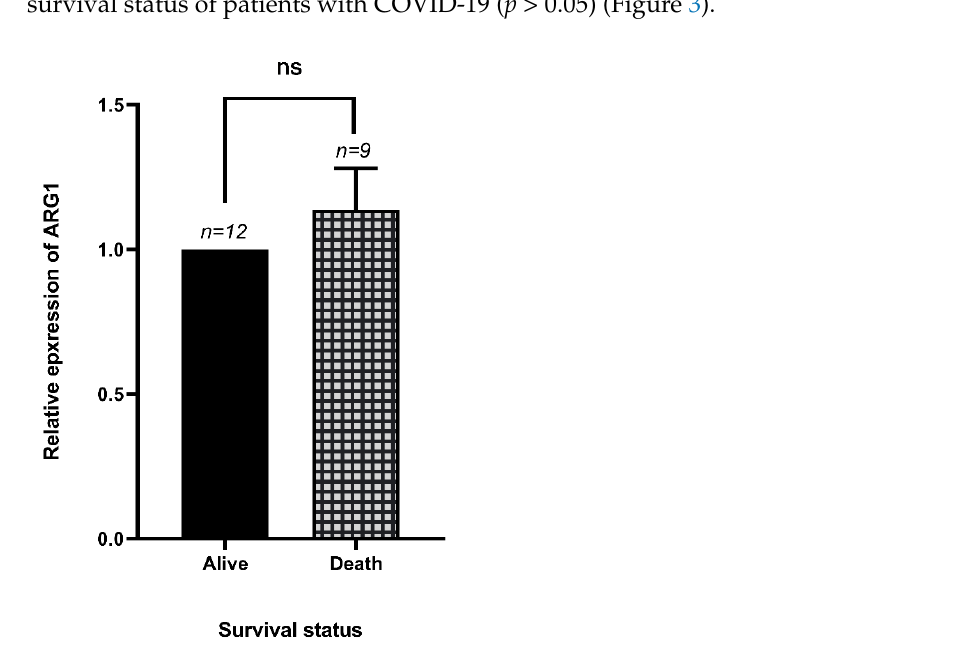
Figure 3. The relative expression of Arg1 in dead and alive patients of COVID-19. There was an increase in the expression of Arg1 in dead COVID-19 patients; however, this change was not significant.